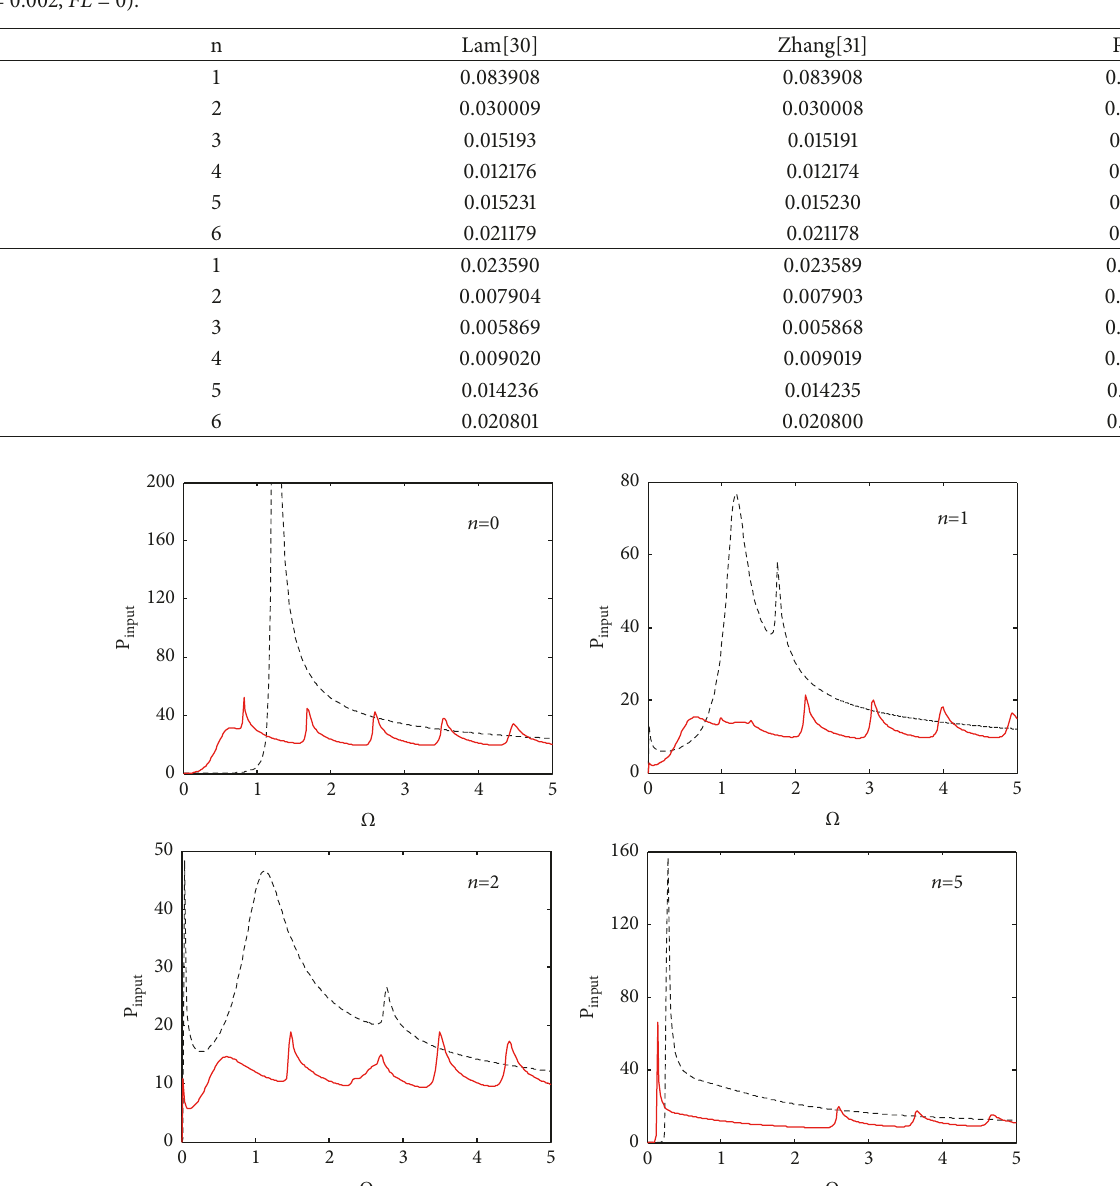
Figure 2: The comparison of nondimensional input power flow into the shell filled and unfilled with water. Black dashed line: in vacuo; red solid line: